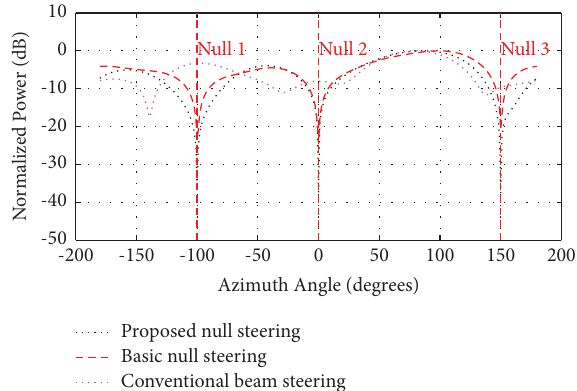
Figure 9: Azimuth cut of the normalized power pattern (at the elevation angle of 40 degrees) in a decibel